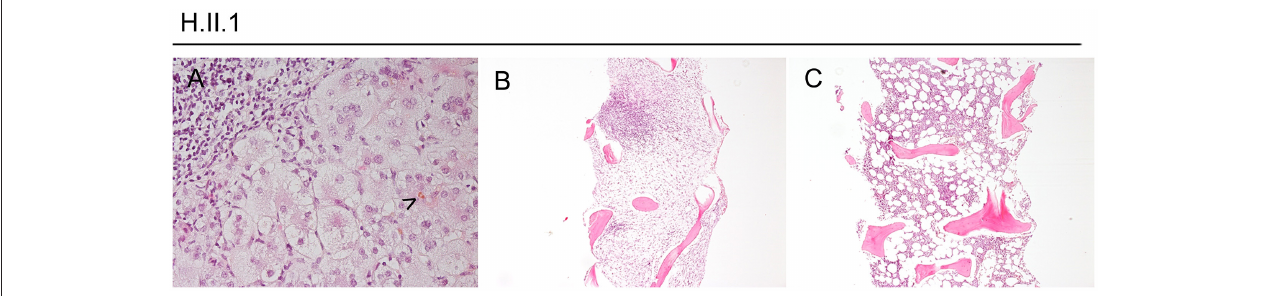
FIGURE 1 | Hyperinflammation, exemplified in a CTLA-4-insufficient-patient. Panel (A) shows a liver biopsy taken from patient H.II.1 at the age of 17 years with a cholestatic giant cell hepatitis (bile marked by arrowhead, exemplary). Panels (B,C) show bone marrow trephine biopsies with nodular lymphocytic aggregates (of T-cell origin, by IHC). In (B) , subtotal replacement of hematopoiesis by fibrosis and stromal edema can be seen.